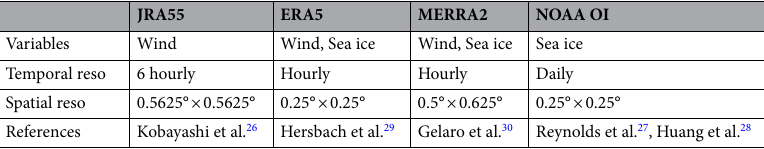
Table 1. List of data products used in this